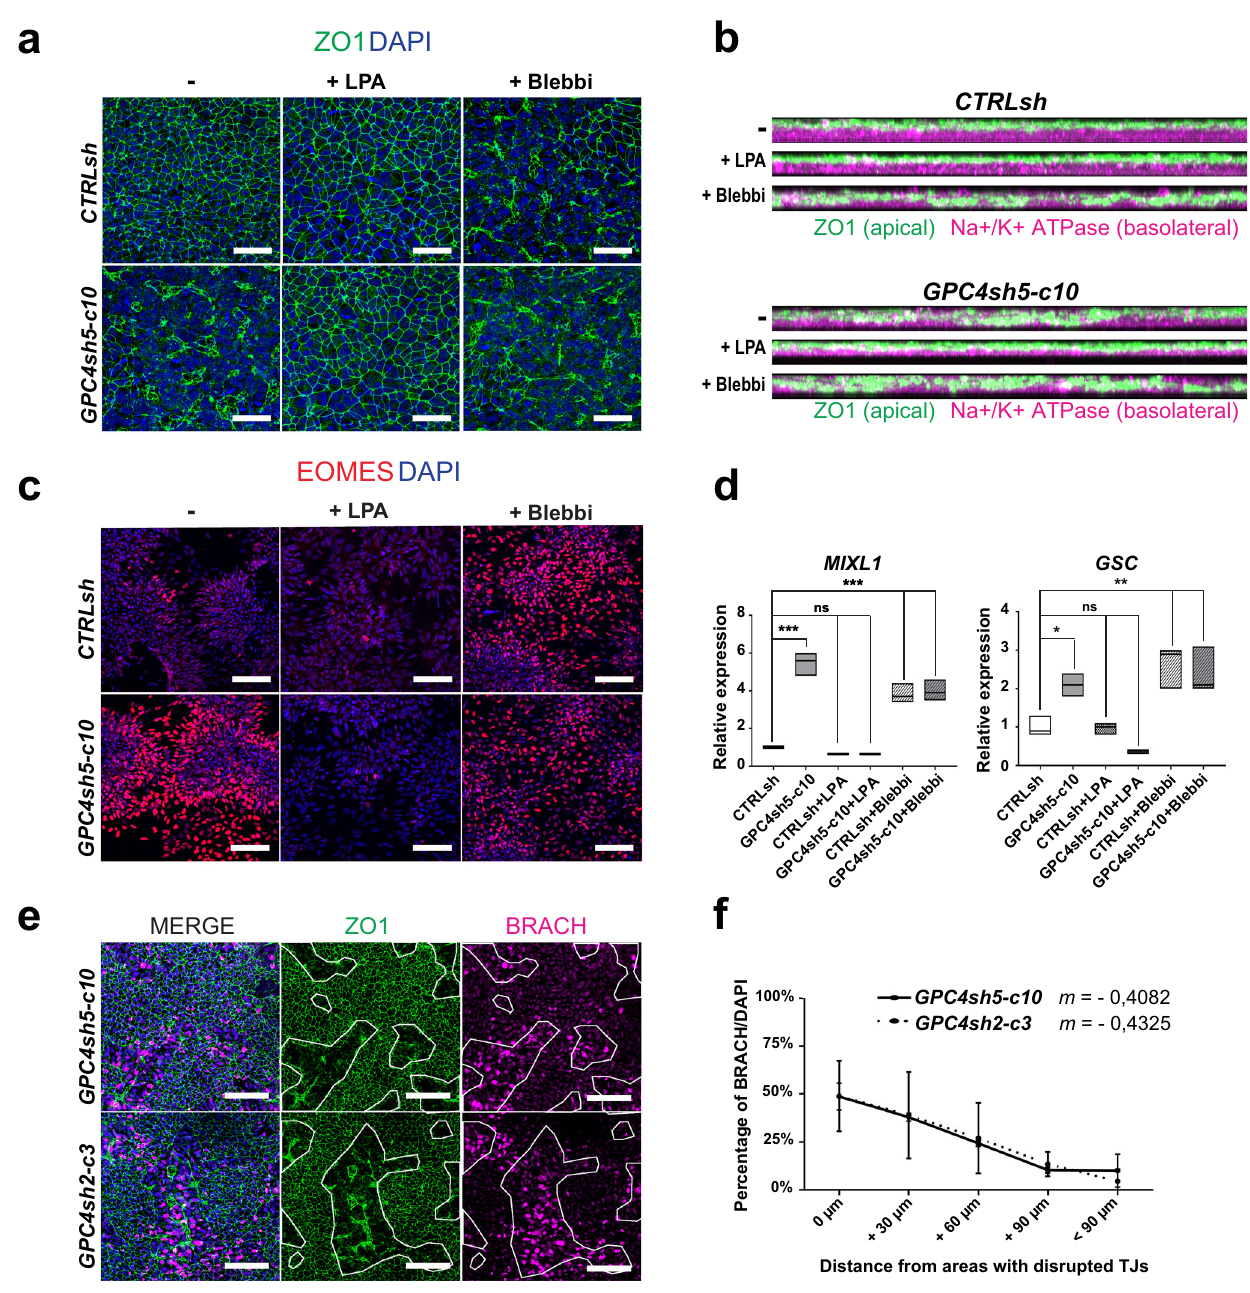
Fig. 5 | MES fate acquisition relies on disruption of epithelial integrity. a CTRLsh and GPC4sh5-c10 029 hiPSCs were treated or not with LPA or Blebbi and subjected to immuno fl uorescence analysis of ZO1 (green), n =3. Scale bar: 100 μ m. b Immuno fl uorescence analysis of ZO1 (green) and Na + /K + ATPase (magenta), in CTRLshandGPC4sh5-c10029hiPSCstreatedornotwithLPAorBlebbi.Picturesare presented as lateral view of stained cells, n =3. c , d CTRLsh and GPC4sh5-c10 029 hiPSCs treated or not with LPA or Blebbi were differentiated into MES and the expressionlevelsofMESspeci fi cmarkerswereanalyzedby( c )immuno fl uorescence analysisofEOMES(red; n =3;Scalebar:100 μ m.)and( d )RT-qPCRanalysesof MIXL1 and GSC transcript levels.Transcript levels were normalized to the Δ Ct of reference WT controlsample.Boxplotsrepresent the medianwith minand maxvalues, n =3. e GPC4sh5-c10 and GPC4sh2-c3 029 hiPSCs were differentiated into MES using